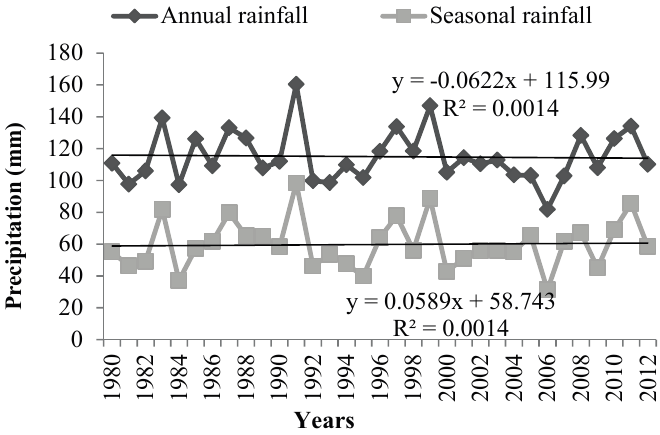
Figure 2. Annual and seasonal rainfall (mm) in the Lawra district of Ghana (The rainfall data was collected directly from the office of the meteorological agency: Ghana Meteorological Agency,